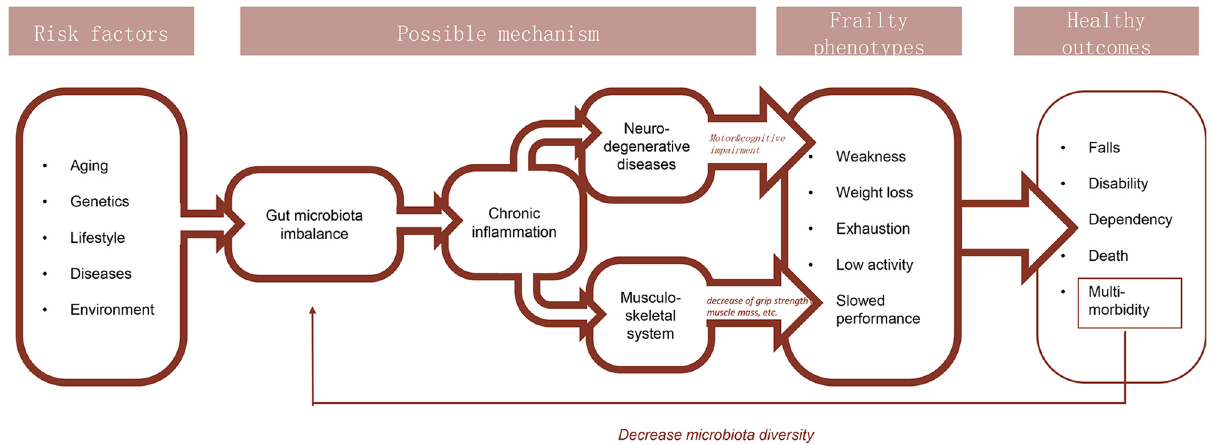
Figure 1: Current understanding of the pathogenesis of frailty